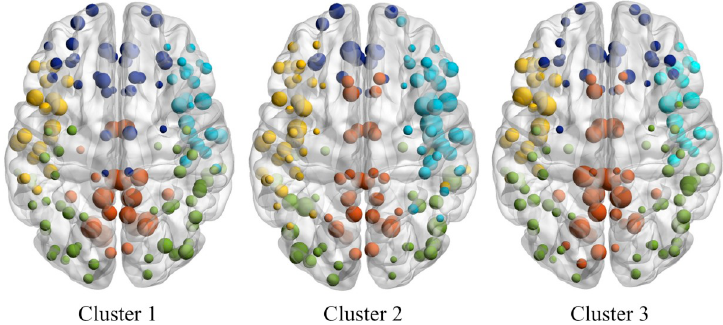
Fig 6. Gyrification network visualization. Visualization of gyrification networks for each neurocognitive cluster. Nodes are plotted by module membership. Greater node size reflects higher node degree (i.e., a greater number of connections). Module 1 (occipito-parietal/midline) = red; Module 2 (fronto-temporal, left hemisphere only) = yellow; Module 3 (occipito-parietal/limbic) = green; Module 4 (fronto-temporal, right hemisphere only) = light blue; Module 5 (frontal) = dark